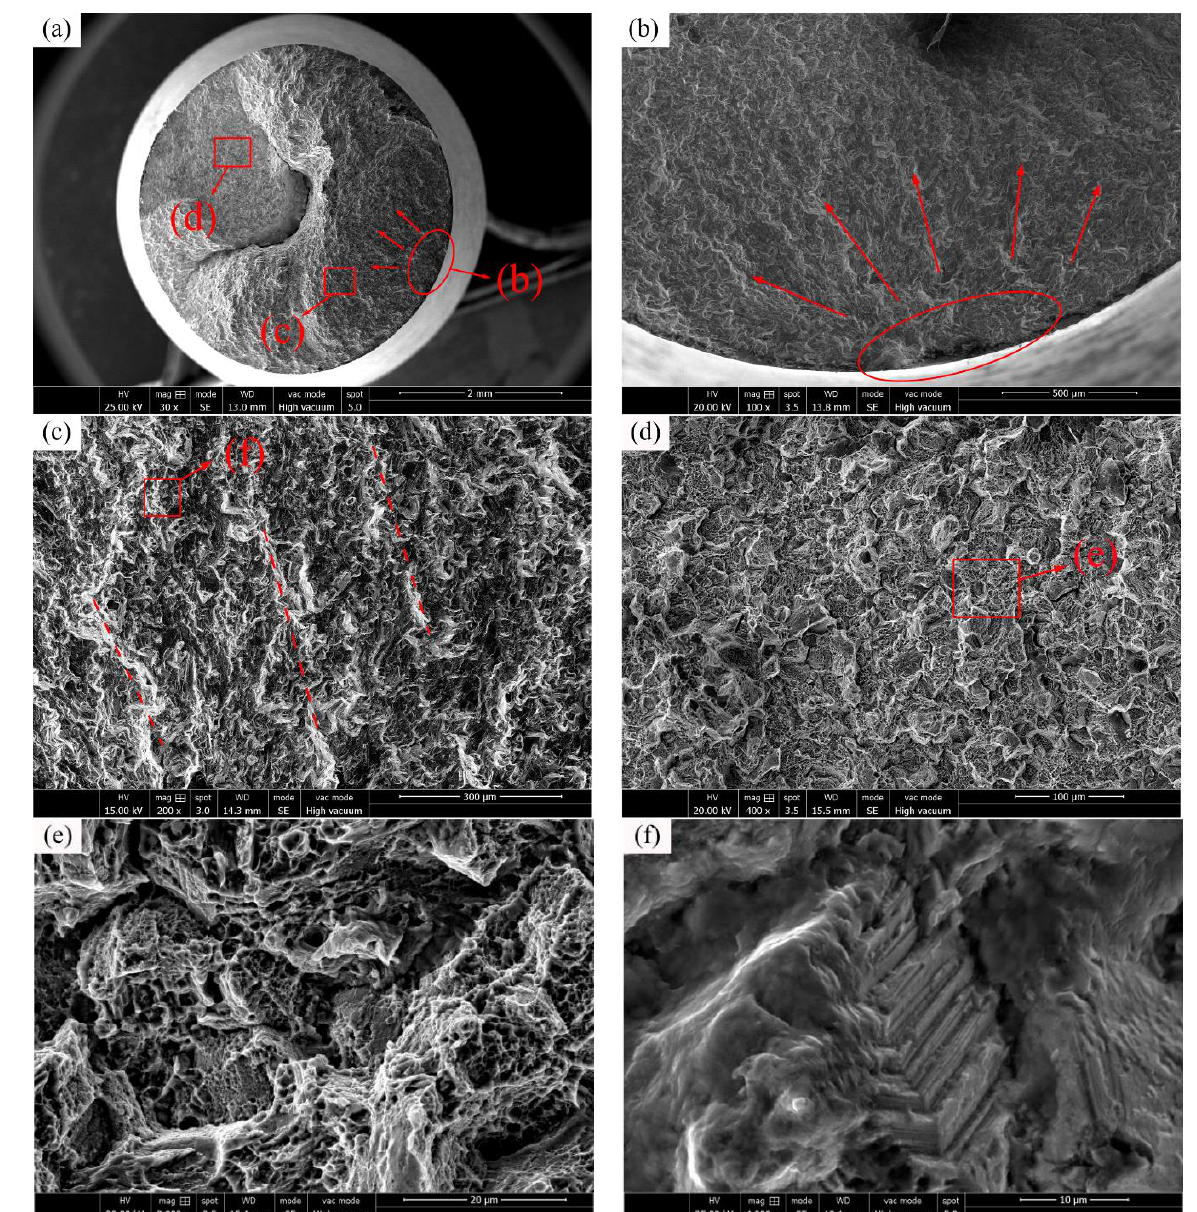
Figure 11. C17200 beryllium copper alloy fractured at 25 °C ( S max = 490 MPa, N f = 0.46 × 10 7 cycles). ( a ) General view of the fatigue-fractured surface; ( b ) crack initiation region; ( c ) crack propagation region; ( d ) final rupture region; ( e ) dimple fracture; and ( f ) fatigue speckle.